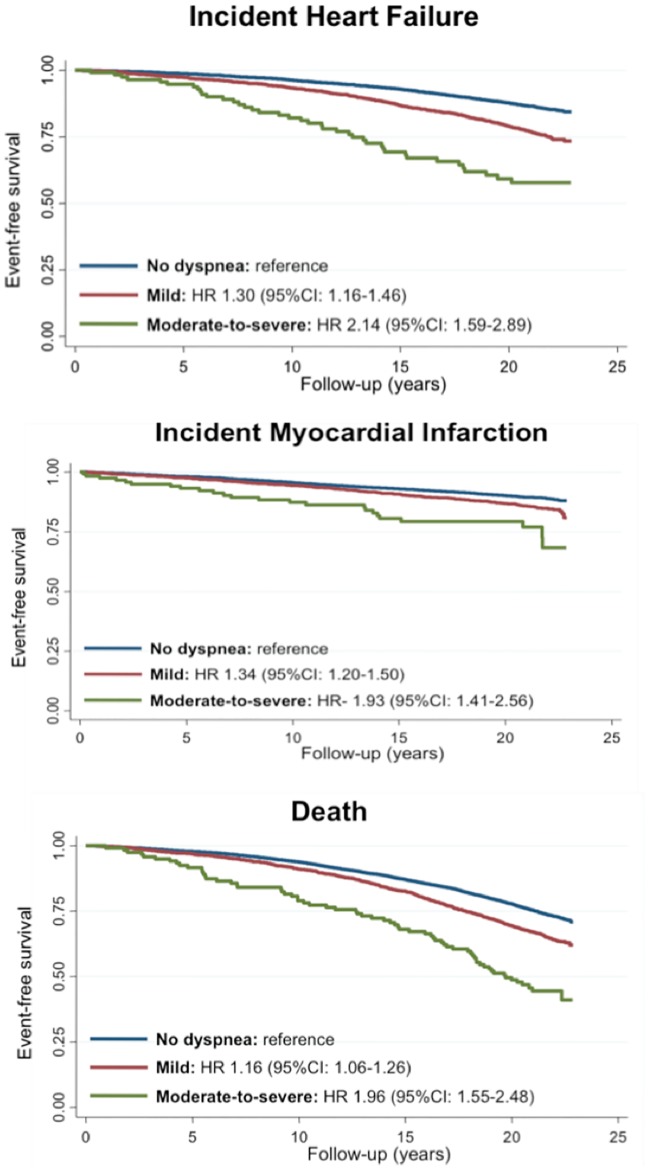
Survival curves of patients with no prevalent CV or pulmonary disease according to dyspnea status regarding death, incident HF and MI.